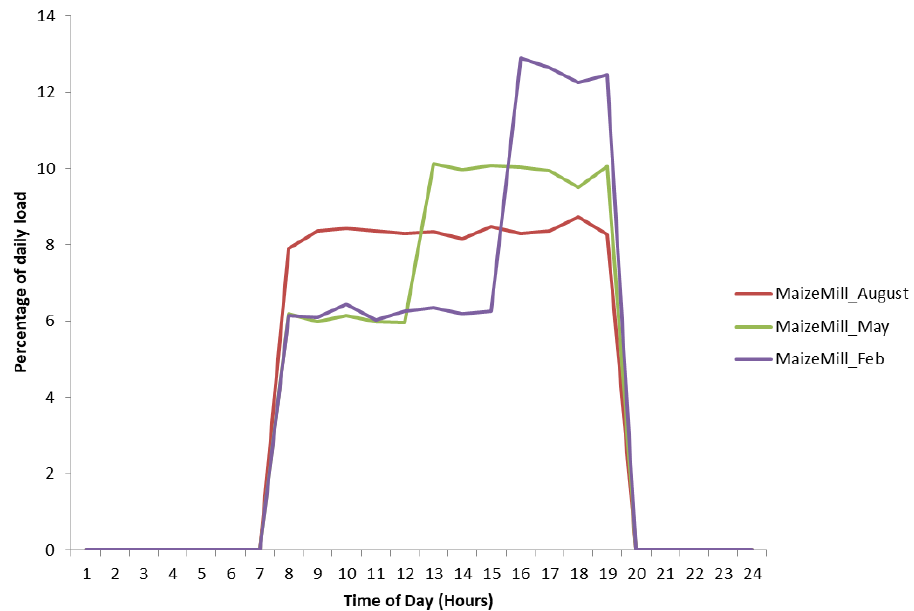
Figure 9. Load profile for the maize mill in August, May, and February.